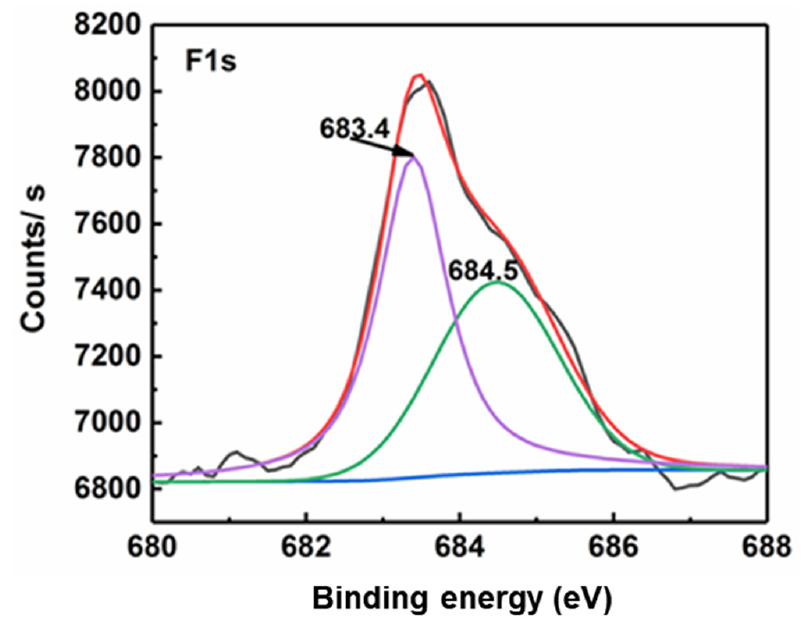
Figure 1. High-resolution XPS spectrum of F1s. From the TEM image of TiO 2 and F-TiO 2 (Figure 2), it is found that the morphology of F-TiO 2 prepared by the hydrothermal method has a very obvious change compared with that of TiO 2 . TiO 2 has an irregular shape, while F-TiO 2 is almost spherical. This is because F − has an etching effect on TiO 2 during hydrothermal treatment [23]. The F − has a strong complexation ability with Ti on the surface of TiO 2 , which corrodes the edges and corners of TiO 2 particles and changes the irregular TiO 2 into a spherical shape